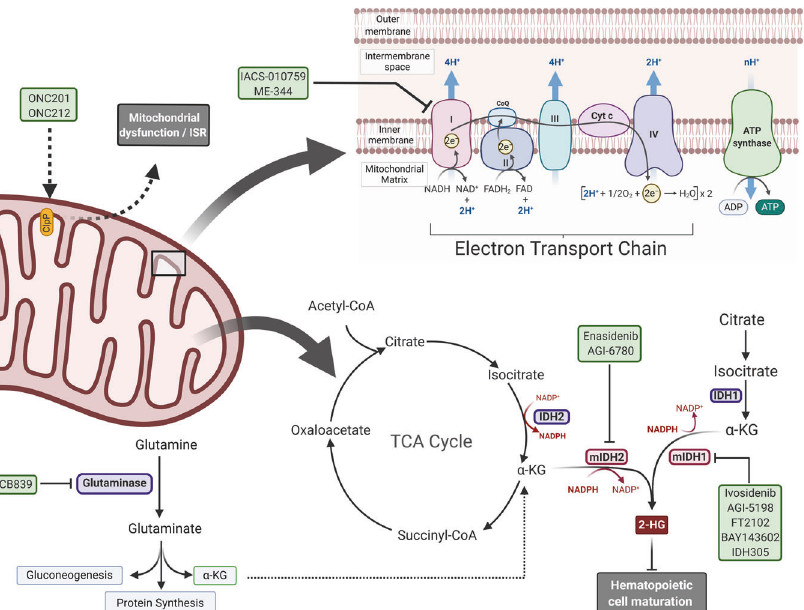
Fig. 4 Targeting AML cell mitochondria function. Expression of gain-of-function mutant IDH1/2 (mIDH) results in the production of oncometabolite, 2-HG, which inhibits maturation of hematopoietic cells and promotes leukemia. Inhibitors speci fi c to mIDH (enasidenib, AGI- 6780, ivosidenib, AGI-5198, FT2102, BAY143602, IDH305) prevent the production of 2-HG and promote differentiation of leukemia cells. CB893, a glutaminase-speci fi c inhibitor, prevents the production of α -ketoglutarate ( α -KG) — a key metabolite for mIDH cell survival. IACS-010759 and ME-344 target AML cell OXPHOS through inhibition of ETC complex I. ONC201/ONC212 induce mitochondrial stress through activation of mitochondrial protease, ClpP, which leads to subsequent mitochondrial dysfunction and AML cell stress